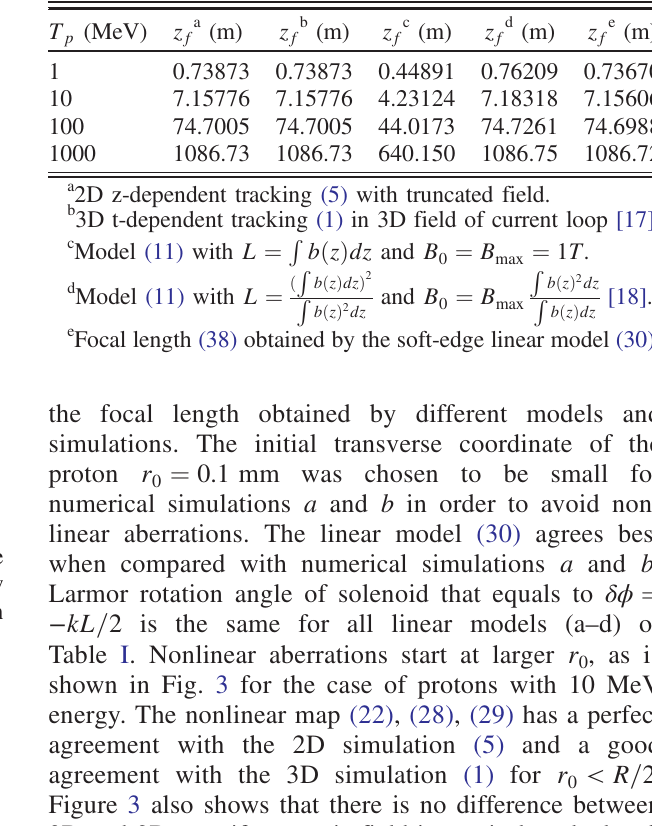
TABLE I. Benchmark of the focal length for different proton energies T p and different models and simulations.